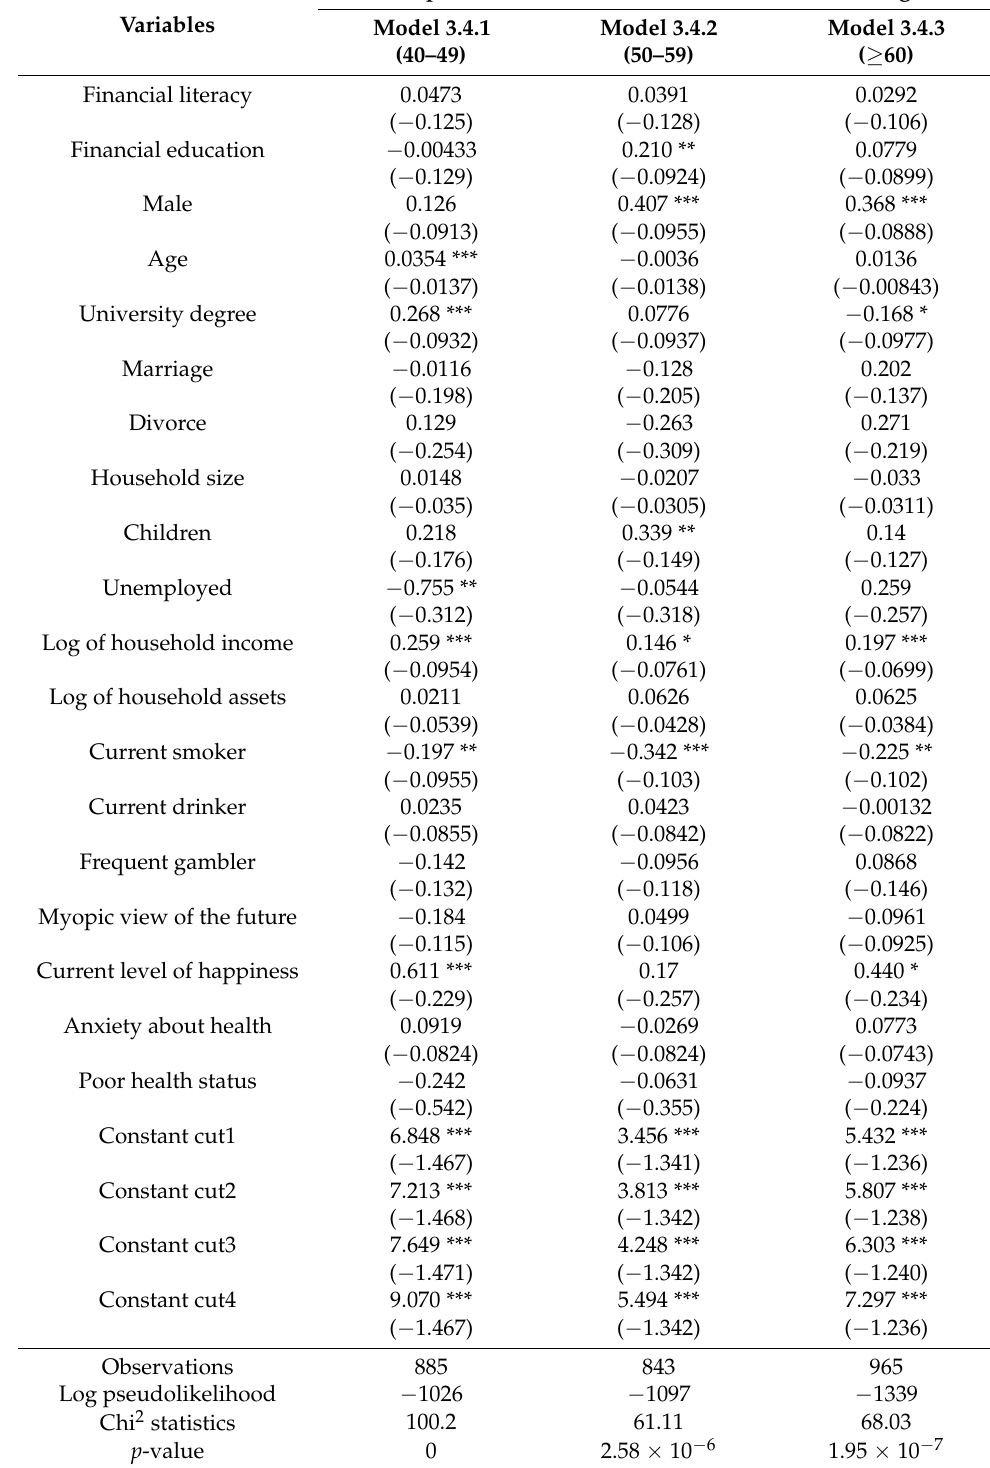
Table 9. Ordered probit model regression results for the number of cancer screenings, stratified by three age